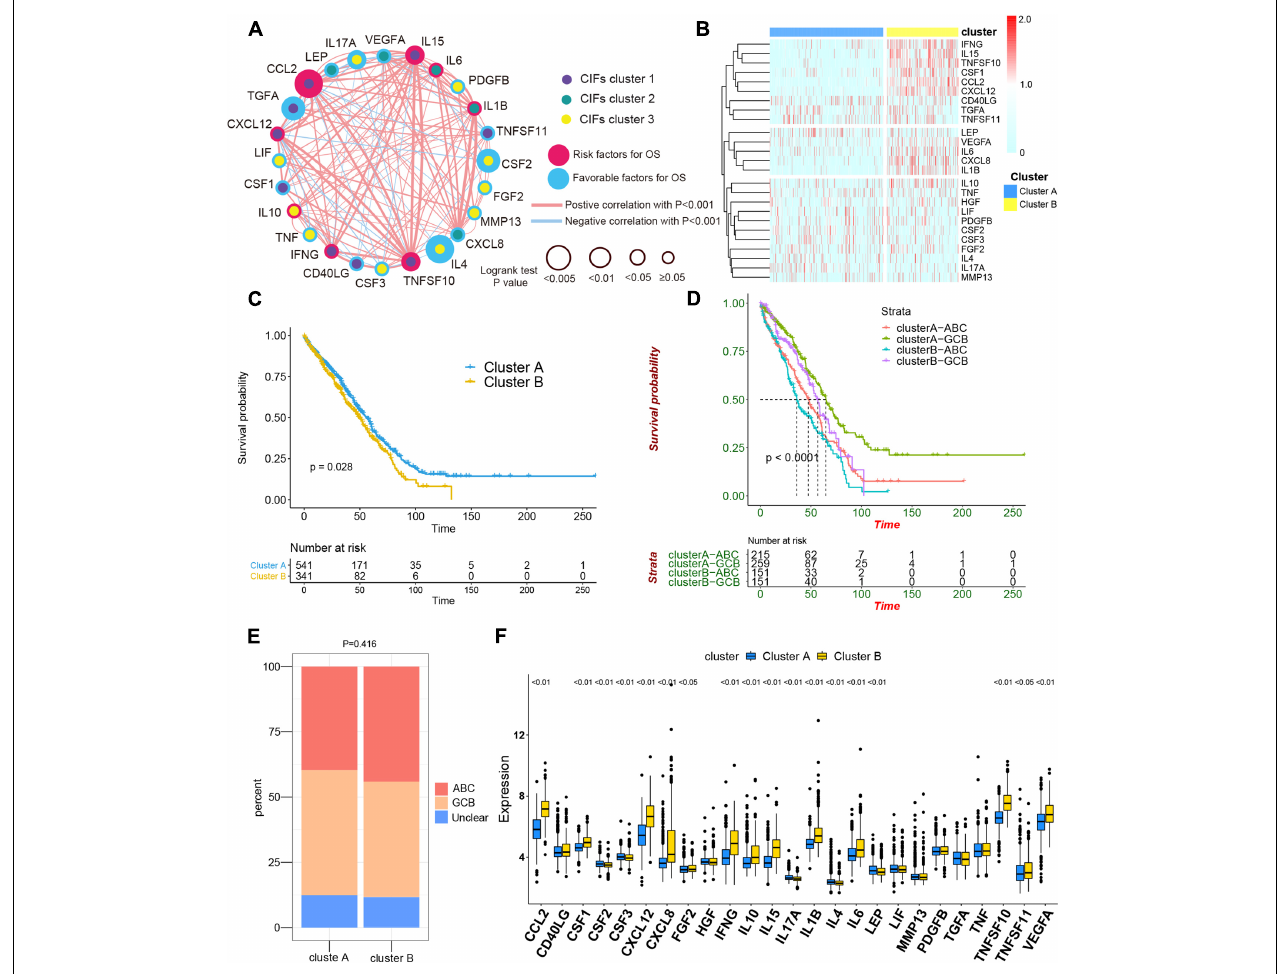
FIGURE 2 | The comprehensive landscape of cachexia-inducing factor (CIF) interactions and identification of two molecular subtypes with different prognoses and transcriptome traits. (A) Network showing the landscape of CIF interactions and their prognostic significance for patients with DLBCL. The circle size represented the effect of each CIF on the prognosis, and the range of values calculated by log-rank test was p < 0.005, p < 0.01, p < 0.05, and P ≥ 0.05, respectively. Red circle, risk factors of prognosis. Blue circle, protective factors of prognosis. The lines linking the CIFs showed their interactions, and the thickness of the connecting line is positively correlated with the strength of the correlation. Negative correlation was marked with blue and positive correlation with red. Dots in the circle represent three CIF gene clusters termed as CIF clusters 1–3 and marked with purple, dark cyan, and yellow, respectively. (B) Heat maps showing the 25 CIFs’ expression level clustered by different subtypes and segregation according to the relevance of CIFs. (C) Survival analyses for the two molecular subtypes based on 882 patients with diffuse large B-cell lymphoma (DLBCL) from two Gene Expression Omnibus cohorts (GSE10846 and GSE31312) including 541 cases in cluster A and 341 cases in cluster B. Kaplan–Meier curves with log-rank p value 0.028 showed a significant survival difference among distinct subtypes. (D) Patients separated by cell of origin (COO) subtype with distinct molecular subtypes have a significantly different prognosis. (E) The proportion of COO subtypes in cluster A and cluster B patients. (F) Difference in the expression of 25 CIFs between cluster A and cluster B subtype